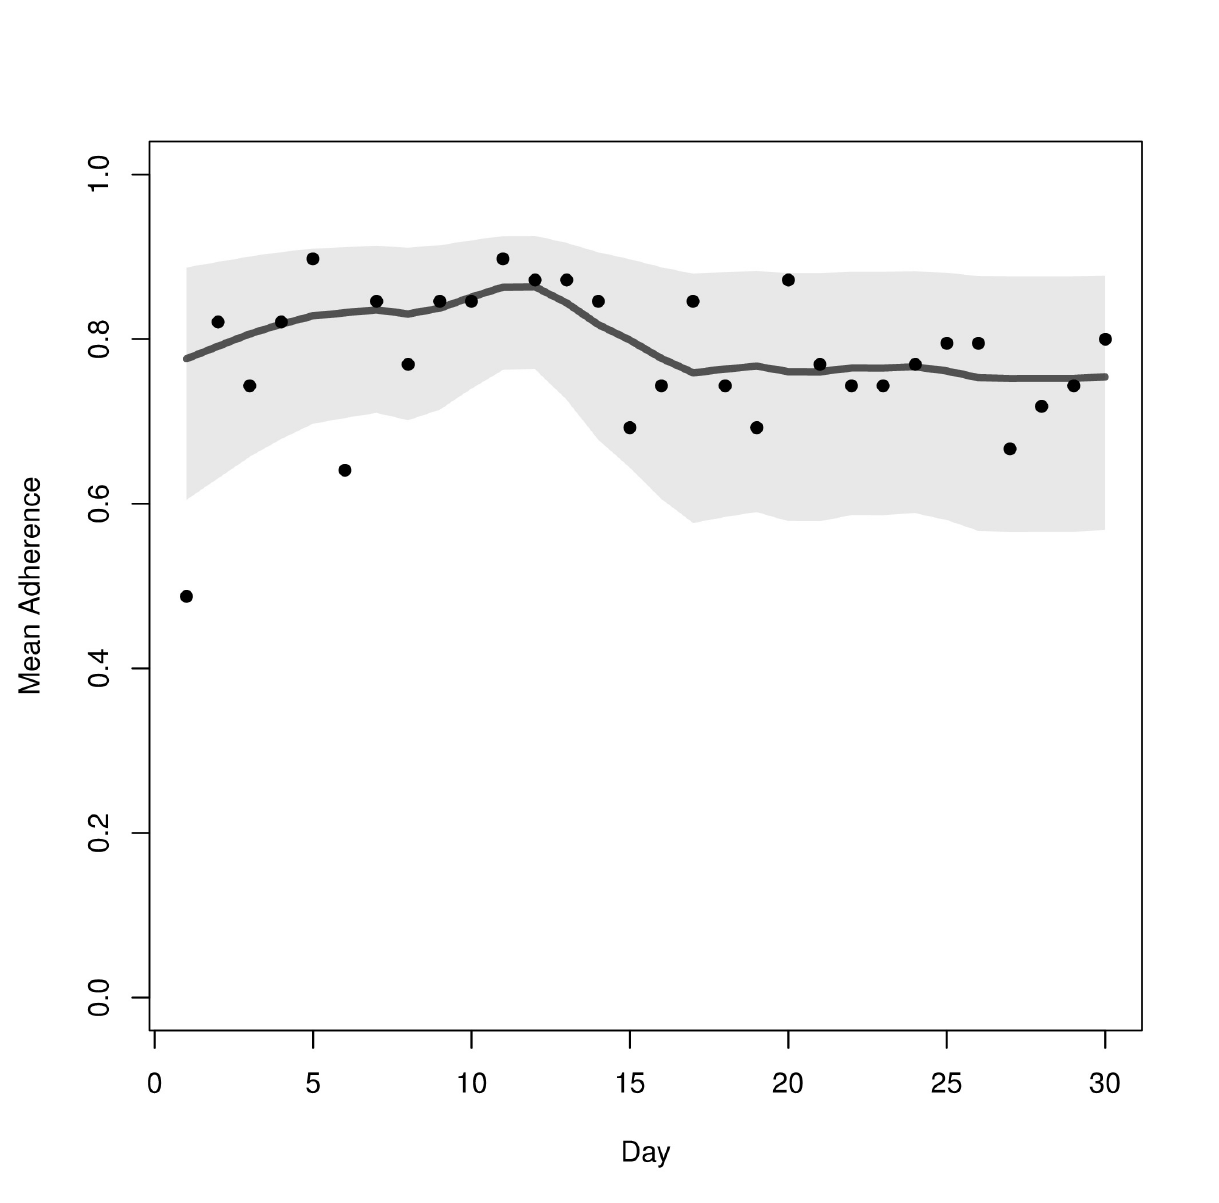
Figure 2. Average adherence to surveys delivered by the customized smartphone app over time (days). Responses were pooled from the three daily surveys: morning, afternoon, and evening. The gray band represents a 95% prediction